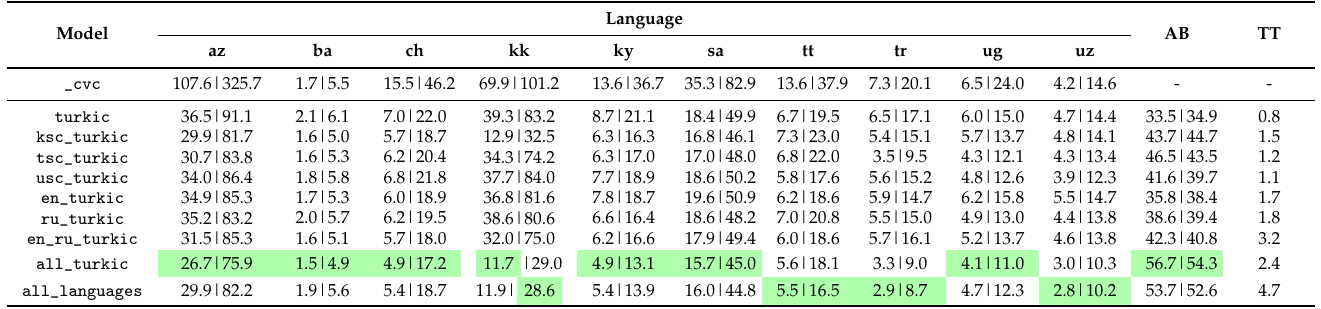
Table 6. The CER (%)| WER (%) results, average boost (AB, %) over the monolingual baseline, and training time (TT, day) of the models on the CVC test sets.